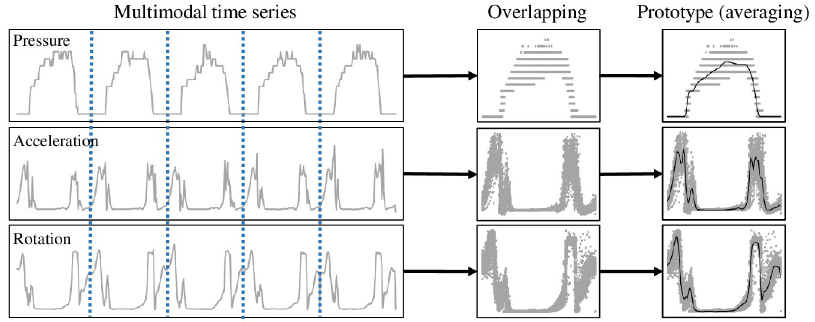
Fig 3. Illustration of computing the prototype of each sensing modality for a subject. The prototypes (bold solid curves in the rightmost figures) of a subject are computed by averaging over all unit steps. For brevity, the L 2 norms of ; and s rot are depicted. s pre i ; a ; s acc i ; a i ; a